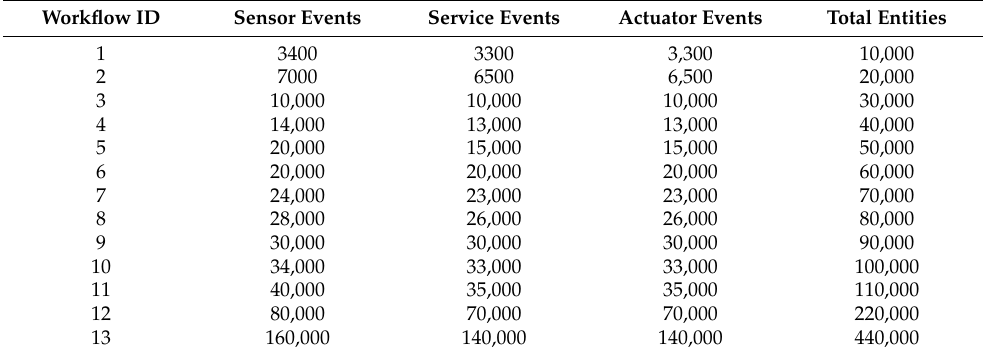
Table 5. The entity number of sensors, services, and actuators in each workflow determines the size of the application.